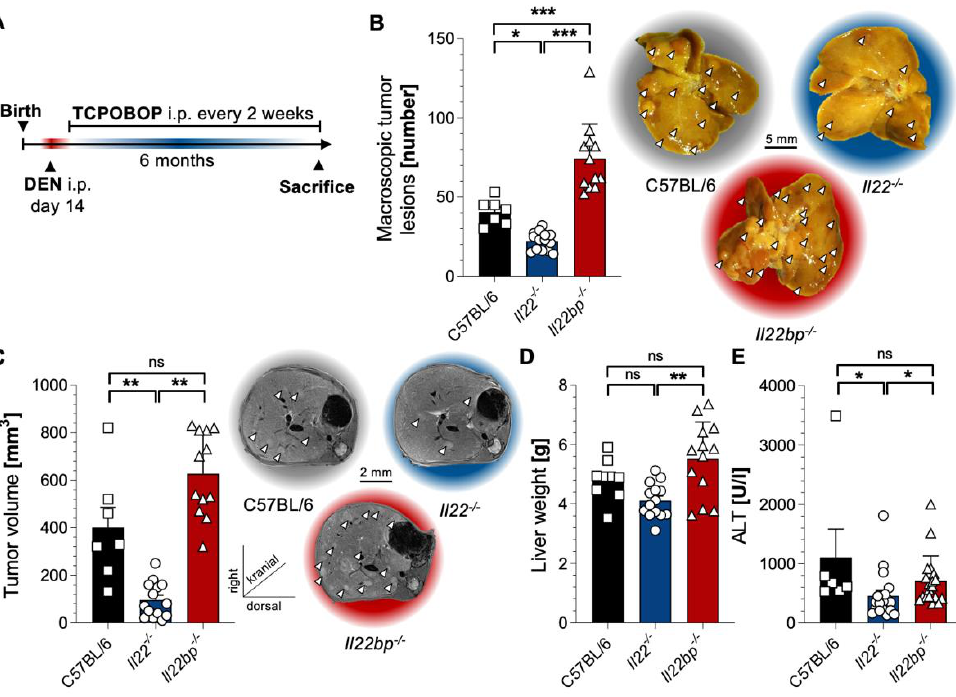
Figure 1. IL-22 and IL-22BP display contrary effects in a chemical mouse model of HCC. ( A ) A schematic timeline describing chemical HCC induction with DEN and TCPOBOP in mice; ( B ) left: number of macroscopic tumor lesions in livers of 6 -month-old mice that were either wild type (C57BL/6, left, black, n = 7), Il22 -deficient ( Il22 -/- , middle, blue, n = 14) or Il22bp -deficient ( Il22bp -/- , right, red, n = 12); right: representative macroscopic pictures; ( C ) left: tumor volume (in mm 3 ) assessed by MRI in livers of 6 month-old mice after HCC induction that were either wild type (C57BL/6, left, black, n = 7), Il22 -deficient ( Il22 -/- , middle, blue, n = 14) or Il22bp -deficient ( Il22bp -/- , right, red, n = 12); right: representative macroscopic pictures; ( D ) liver weight of 6 -month-old mice after HCC induction that were either wild type (C57BL/6, left, black), Il22 -deficient ( Il22 -/- , middle, blue) or Il22bp -deficient ( Il22bp -/- , right, red); ( E ) serum ALT levels (in U/l) of 6-month-old mice after HCC induction that were either wild type (C57BL/6, left, black), Il22 -deficient ( Il22 -/- , middle, blue) or Il22bp -deficient ( Il22bp -/- , right, red). Data are pooled from 2 independent experiments. Data presented as mean ± SEM. ns: p > 0.05; *: p < 0.05; **: p ≤ 0.01; ***: p ≤ 0.001 as assessed by Mann – Whitney U test.